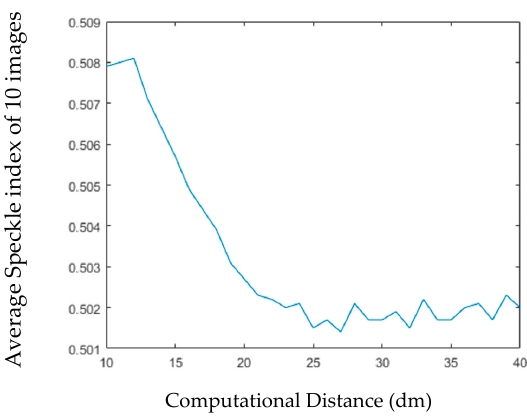
Figure 14. The Relationship between Computational Distance and Imaging Quality.